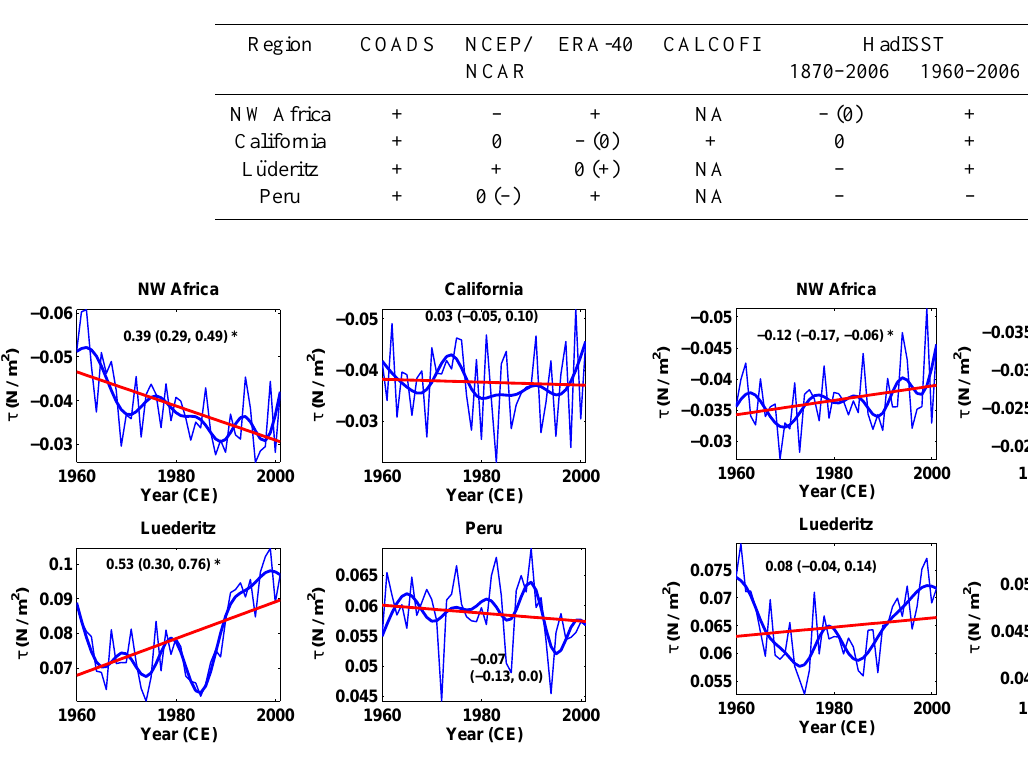
Table 1. Summary of the inferred changes in 20th century upwelling intensity. A + sign represents an increasing trend, a − sign a decreasing trend and 0 a statistically insignificant trend. Deviation from analysis done on unsmoothed time series is shown by values in paranthesis.